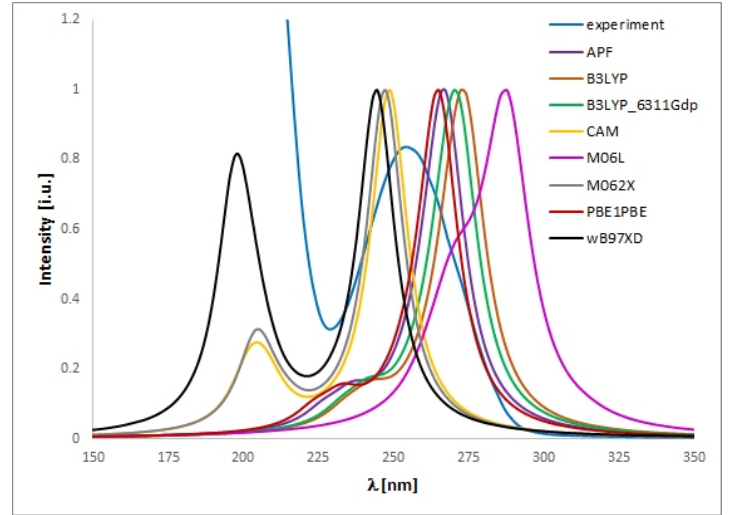
Figure 7. Experimental (experimental) and theoretical UV-vis spectra of bifonazole 2 registered in methanol and computed using CPCM solvation model (methanol as solvent); approximations: APF -APF/6-311++G(2d,3p)//APF/6-31G(d,p), B3LYP -B3LYP/6-311++G(2d,3p)//B3LYP/6-31G(d,p), B3LYP_6311_Gdp- B3LYP/6-311++G(2d,3p)//B3LYP/6-311++G(d,p), CAM -CAM- B3LYP/6-311++G(2d,3p)//CAM-B3LYP/6-31G(d,p), M06L -M06L/6-311++G(2d,3p)//M06L/6- 31G(d,p), M062X -M062X/6-311++G(2d,3p)//M062X/6-31G(d,p), PBE1PBE -PBE1PBE/6- 311++G(2d,3p)//PBE1PBE/6-31G(d,p). Table 5. First excited states of the isoconazole 1 computed using LR TD DFT approach in vacuum or in methanol; B3LYP/6-311++G(2d,3p)//B3LYP/6-31G(d,p) level of theory. Compound 1